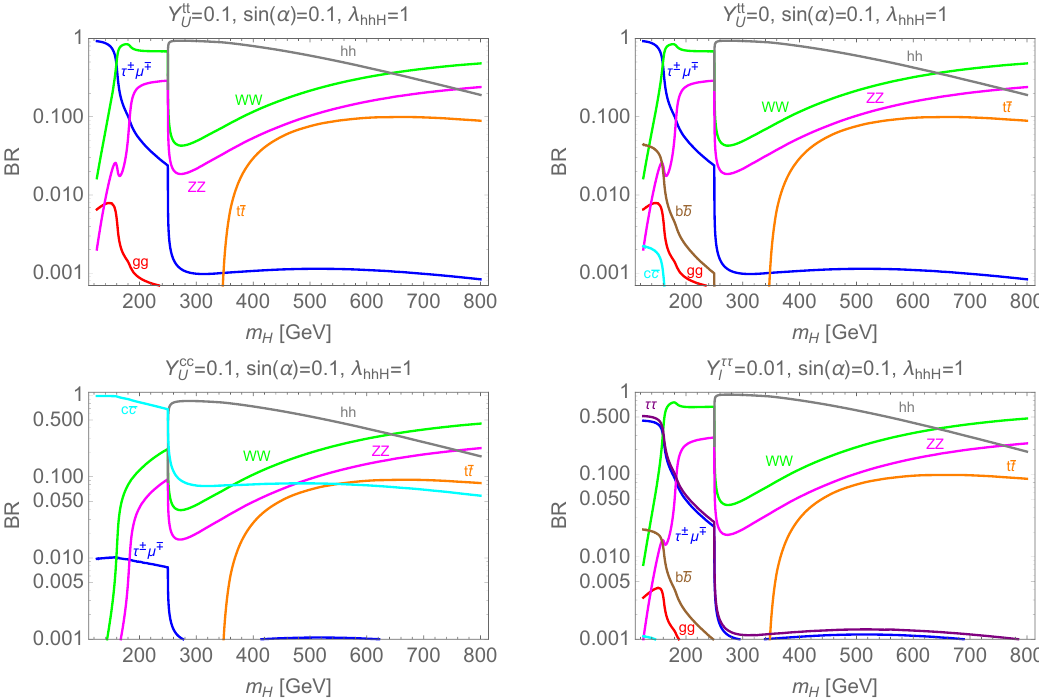
Figure 4. The branching ratios of the heavy neutral scalar H as a function of its mass. The decay into (cid:28) (cid:6) (cid:22) (cid:7) is shown in blue, the t (cid:22) tA in orange, the digluon in red, the W (cid:6) W (cid:7) in green, the ZZ in magenta, the hh in gray, the b (cid:22) b in brown, the c (cid:22) c in cyan and the (cid:28) + (cid:28) (cid:0) in purple. In all plots, Y (cid:28)(cid:22) = Y (cid:22)(cid:28) = 0 : 01, sin (cid:11) = 0 : 1 and (cid:21) hhH = 1. On the upper left, Y tt ‘ ‘ right Y tt = 0, on the bottom left Y cc = 0 : 1 and on the bottom right Y (cid:28)(cid:28) U U couplings are taken to be 0.